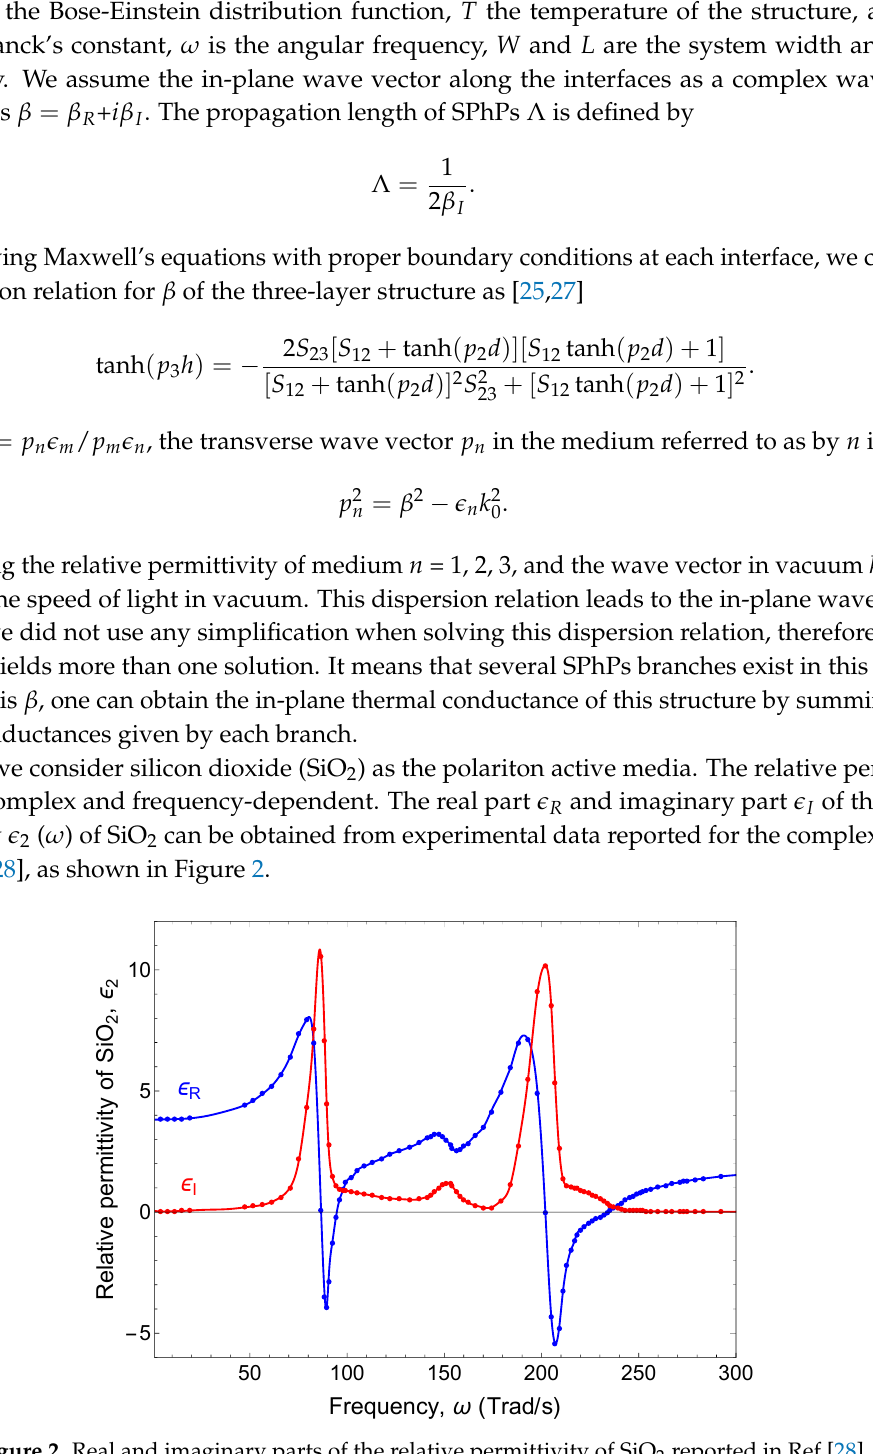
Figure 2. Real and imaginary parts of the relative permittivity of SiO 2 reported in Ref